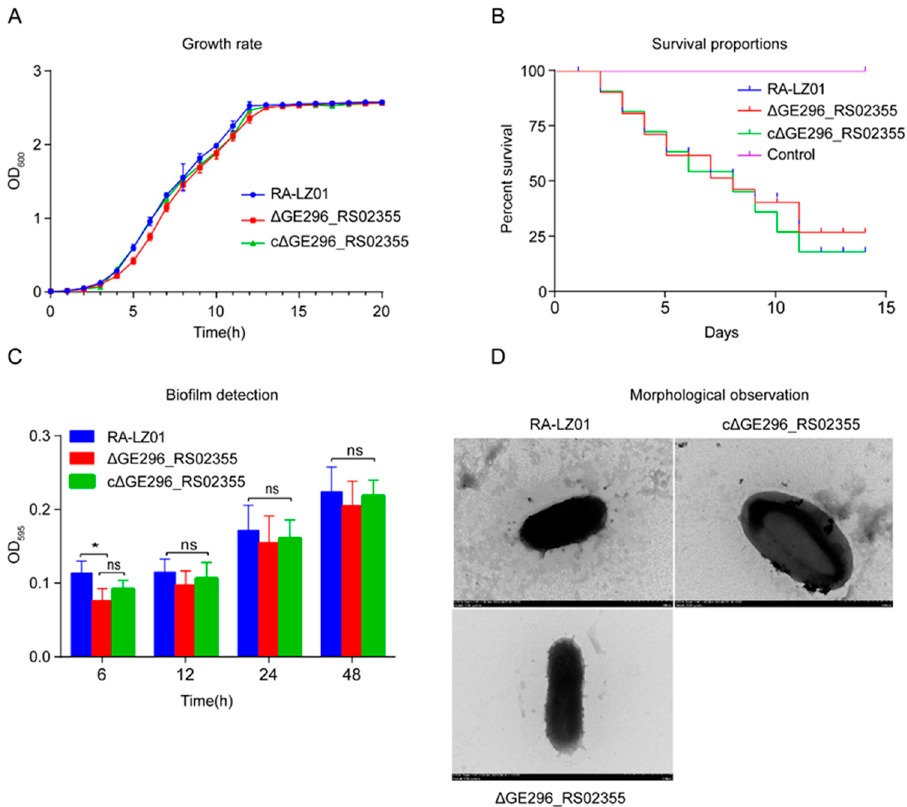
Figure 5. Characterization of parent strain RA-LZ01 and mutant strain. ( A ) Growth curves of RA-LZ0, Δ RanQ , and c Δ RanQ in TSB. ( B ) The virulence experiment of R. anatipestifer WT RA-LZ01, ∆ RanQ , and c ∆ RanQ infecting ducklings. ( C ) The biofilm formation ability of R. anatipestifer WT RA-LZ01, ∆ RanQ , and c ∆ RanQ were analyzed. Each point represents the mean ± standard for triplicate samples. (* p < 0.05, ns p > 0.05). ( D ) Morphological observation of